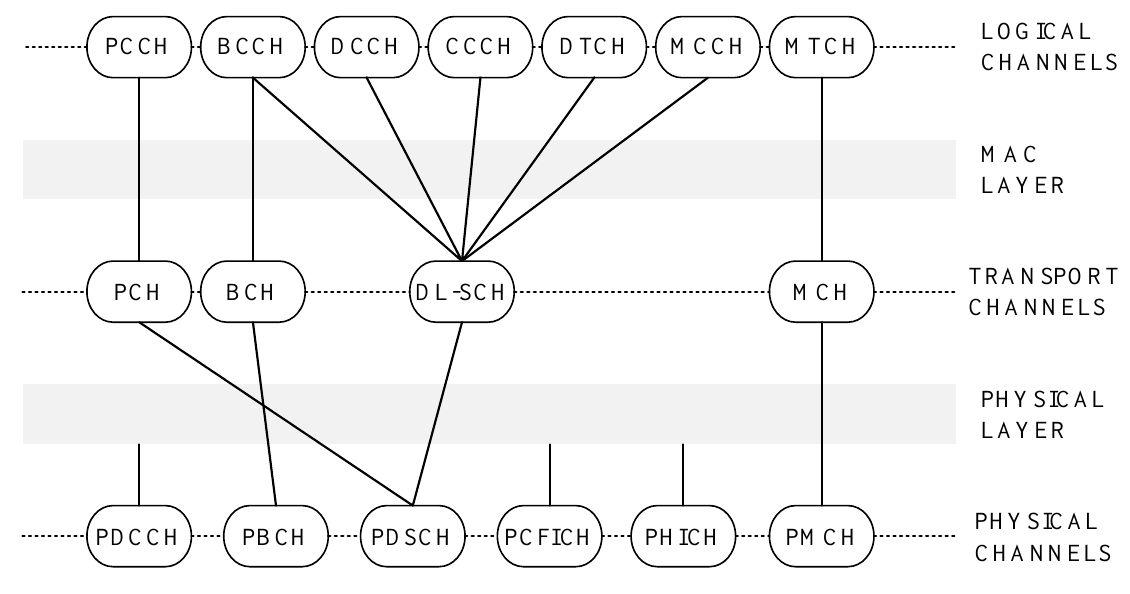
Figure 2 . Physical and MAC Layers in